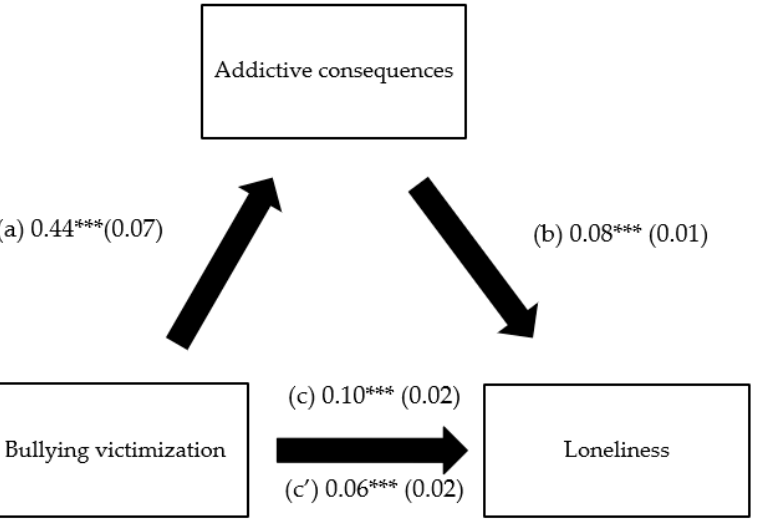
Figure 3. ( a ) Relation between bullying victimization and addictive consequences of problematic use of social network (R 2 = 0.119); ( b ) relation between addictive consequences of problematic use of social network and loneliness (R 2 = 0.254); ( c ) total effect of the relation between bullying victimization and loneliness (R 2 = 0.153); ( c’ ) direct effect of the relation between bullying victimization and loneliness. Numbers are displayed as regression coefficients (standard error). *** p < 0.001.